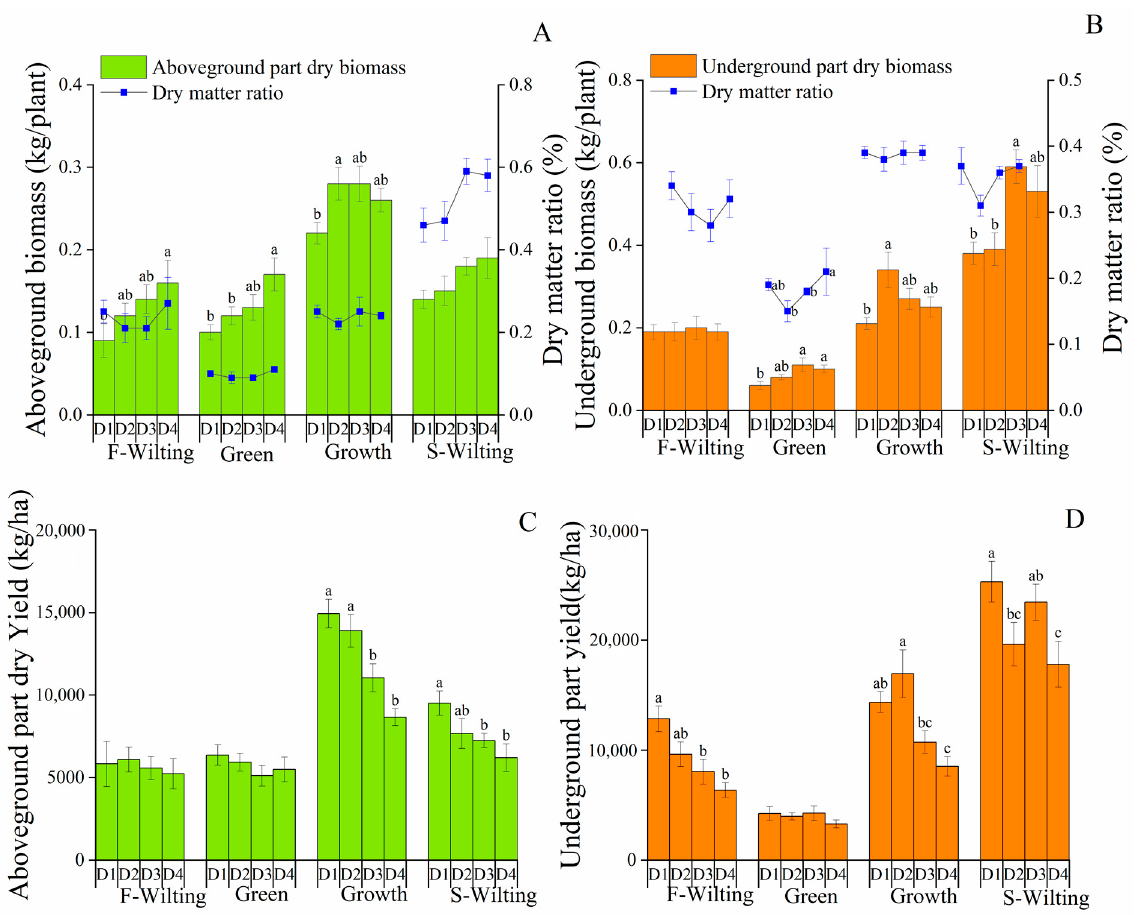
Figure 1. Biomass accumulation (( A ) Aboveground; ( B ) Underground) and yield (( C ) Aboveground; ( D ) Underground) at different density gradients. Different letters indicate a significant difference between treatments at p < 0.05 level.